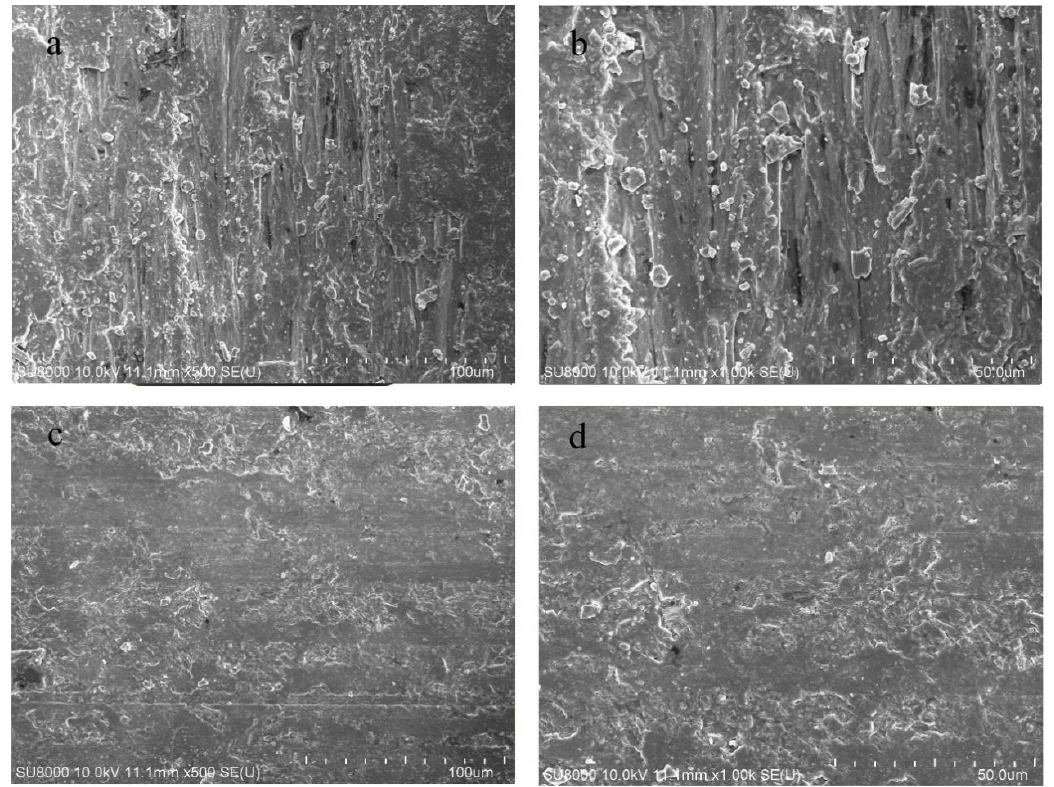
Figure 8. The micromorphology of minerals in cabochon specimen S 1 of Lvwen stone (SEM images). Figure ( a , b ) are 500 × and 1000 × images of white bands, respectively; ( c , d ) are 500 × and 1000 × images of green matrix, respectively.